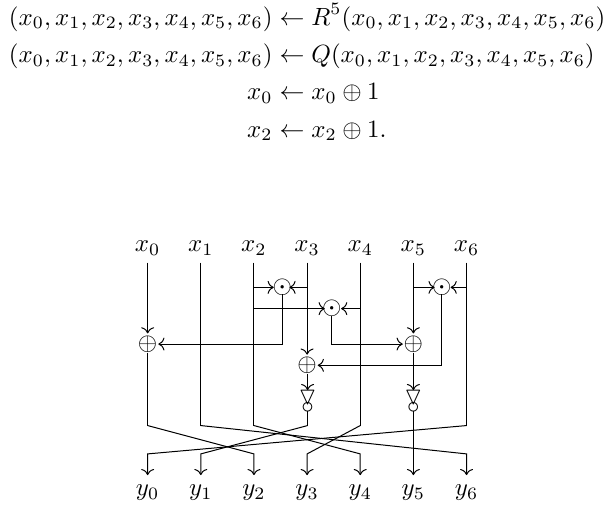
Figure 3: A block diagram of R